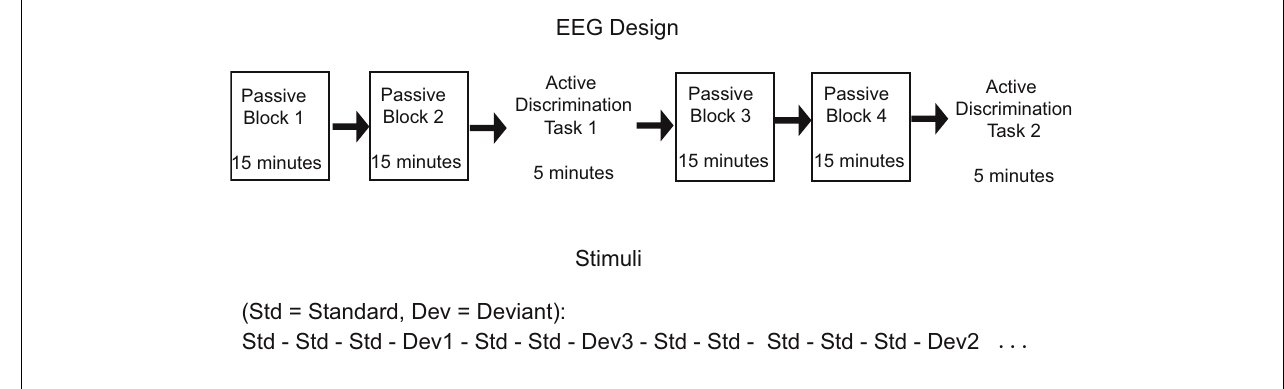
FIGURE 1 | EEG design and